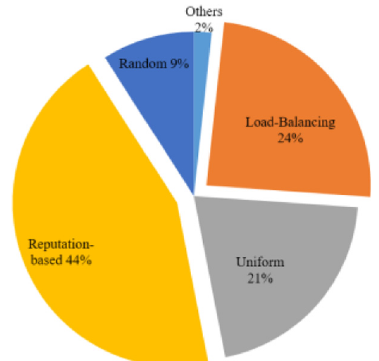
Figure 4. The agile manager